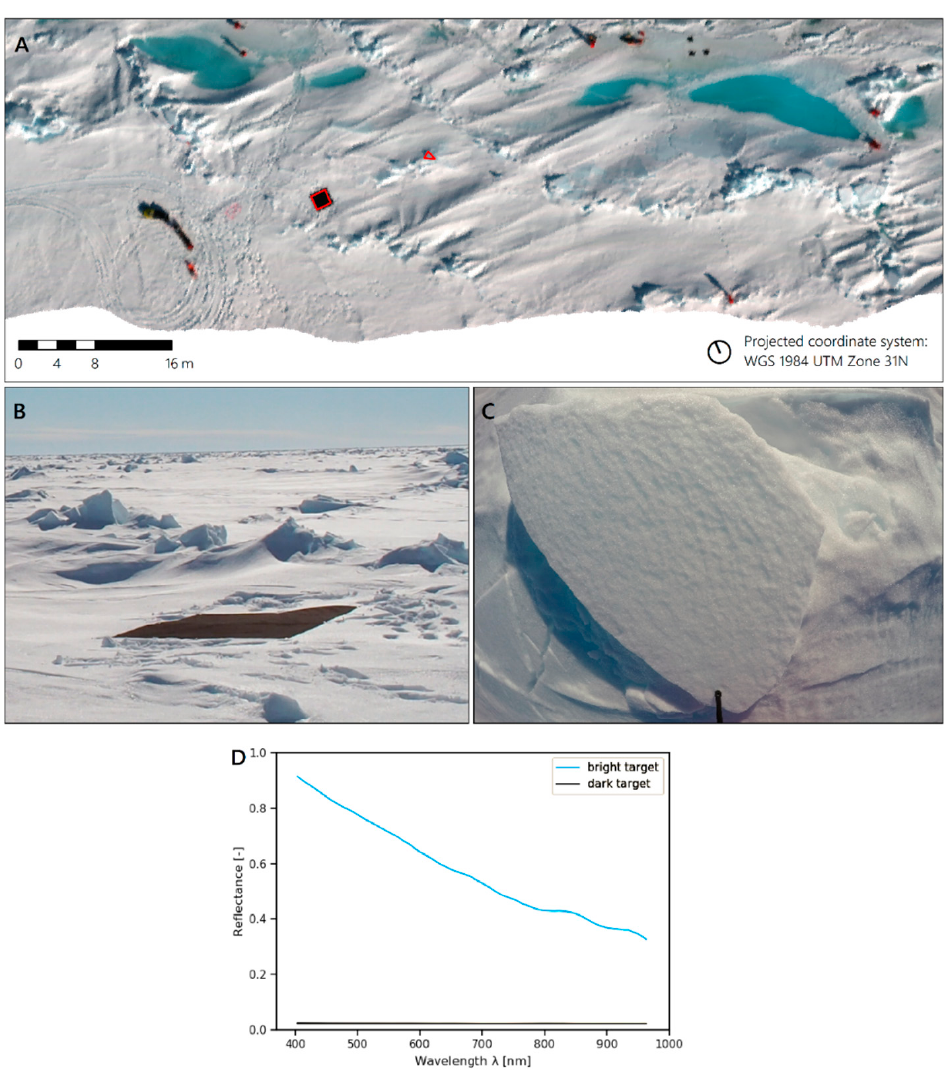
Figure 3. Location of reference measurements. ( A ) illustrates the location of the black target and the ice surface (red polygons) within the flight stripe; Background: AisaEAGLE flight stripe (spatial resolution: 8.5 cm, RGB: 661.16, 550.25, and 482.57 nm). ( B ) is a photo of the black target (Photo: